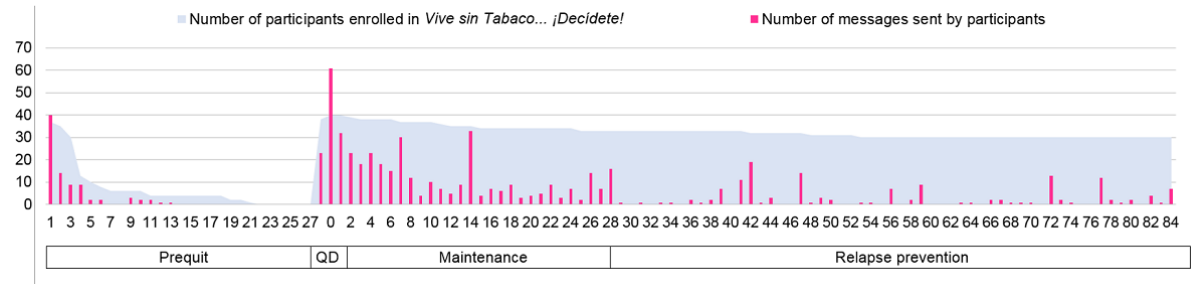
Figure 2. Text messages interaction by participants during the intervention. QD: quit day.